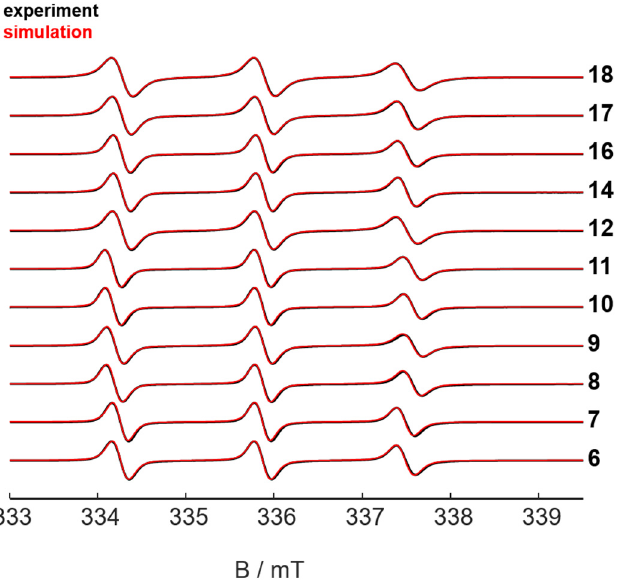
Figure 2. Experimental room temperature CW EPR (X-band, microwave frequency ≈ 9.4 GHz) spectra (black) and the corresponding simulations (red) of the synthesized nitroxide conjugates are given.